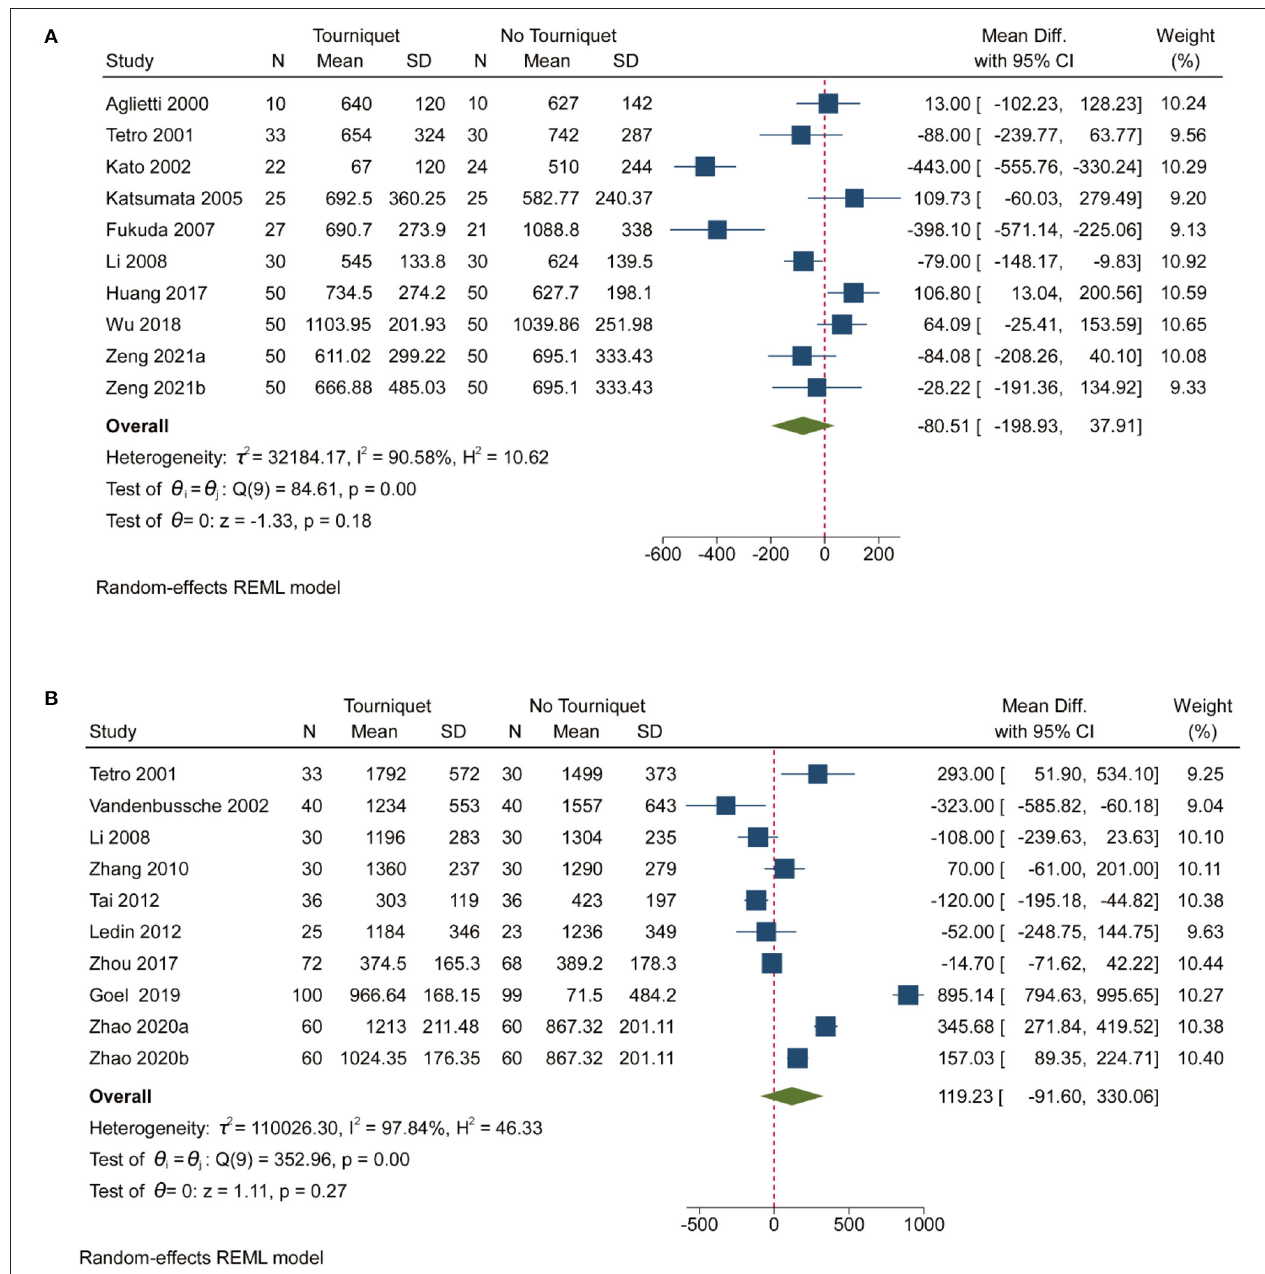
FIGURE 3 | Forest plot for measured total blood loss and calculated total blood loss. (A) . Forest plot comparing measured total blood loss in no tourniquet and tourniquet groups; (B) . Forest plot comparing calculated total blood loss in no tourniquet and tourniquet groups.